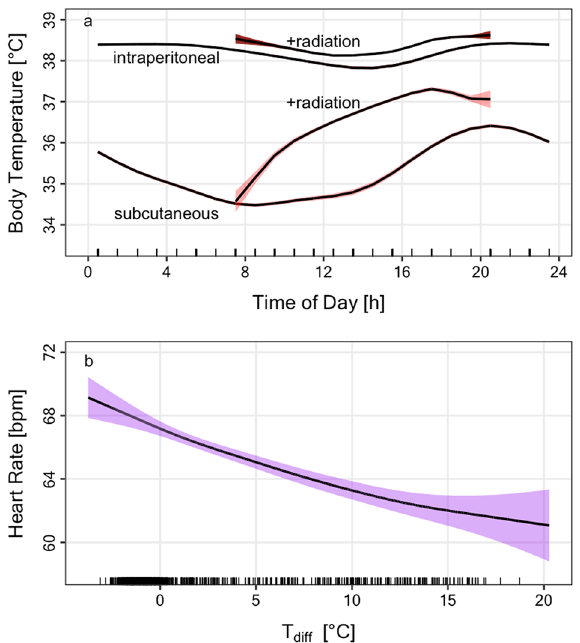
Figure 4. Basking in wild boars. ( a ) Daily time course of intraperitoneal body temperature (T ip ) and subcutaneous body temperature T sc for times at which solar radiation was low or high (+ radiation). Radiation was considered high when black bulb temperature was above the median, i.e., more than + 5 °C above air temperature. Radiation facilitated re-warming of the body shell and was associated with lower HR. ( b ) Effect of solar radiation (back bulb temperature (T abb )—ambient temperature (T a )) on HR in wild boars. Predictions from a GAMM model simultaneously adjusting for T a . Coloured areas in both panels indicate 95% confidence intervals.